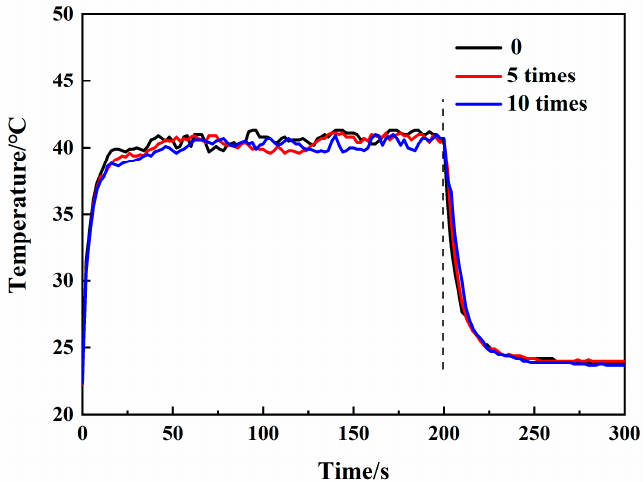
Figure 8. The heating performance of the fabric washed with 0, 5 and 10 times.